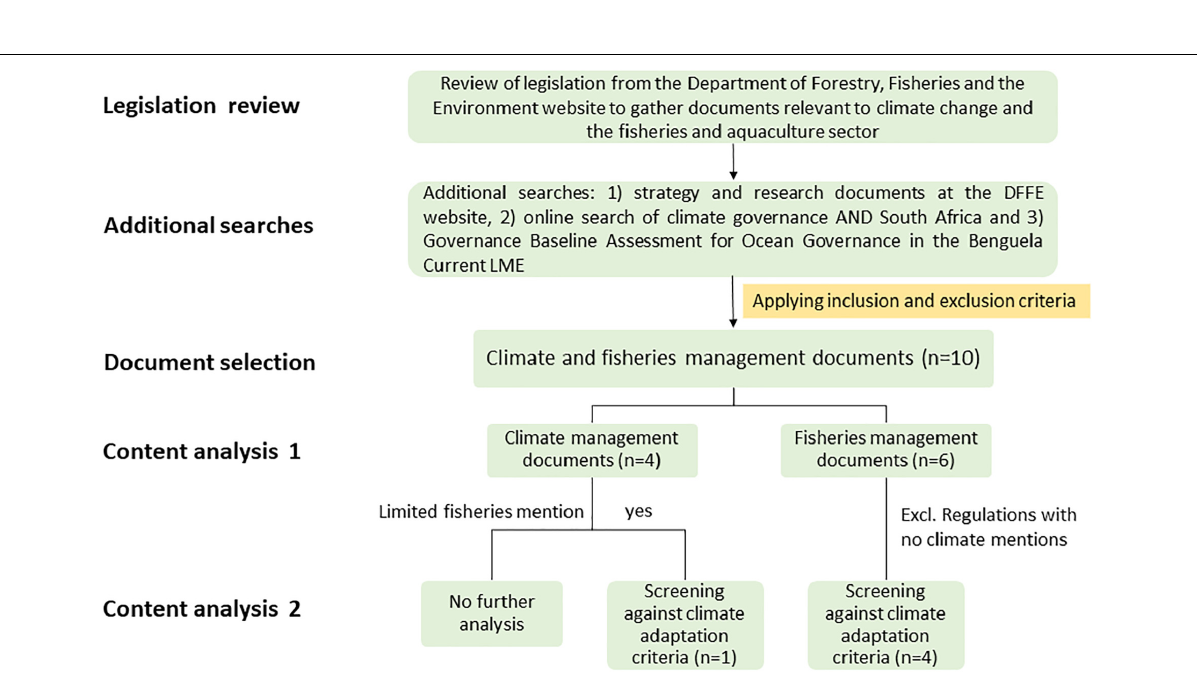
FIGURE 3 | Schematic representation of the methods used in this